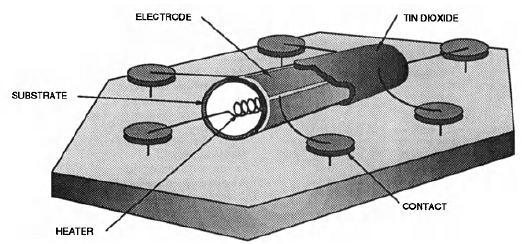
Figure 2. The structure of a Taguchi gas sensor, from ref. [19].